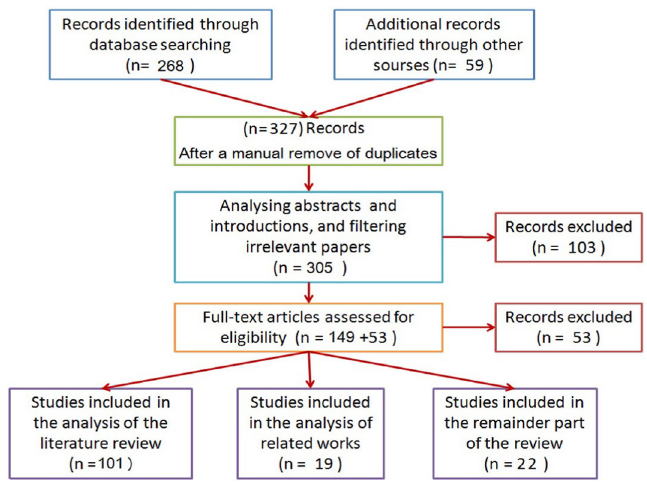
Fig. 3 The research methodology